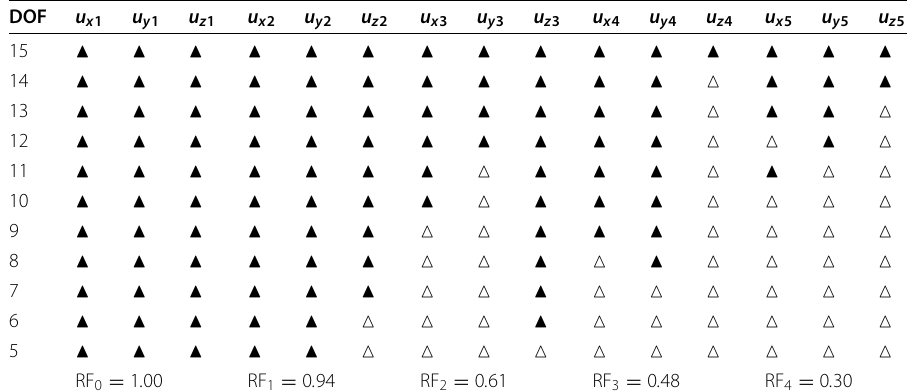
Table 7 BTD models for 0/90/0/90, R/a = 5 , a/h = 100